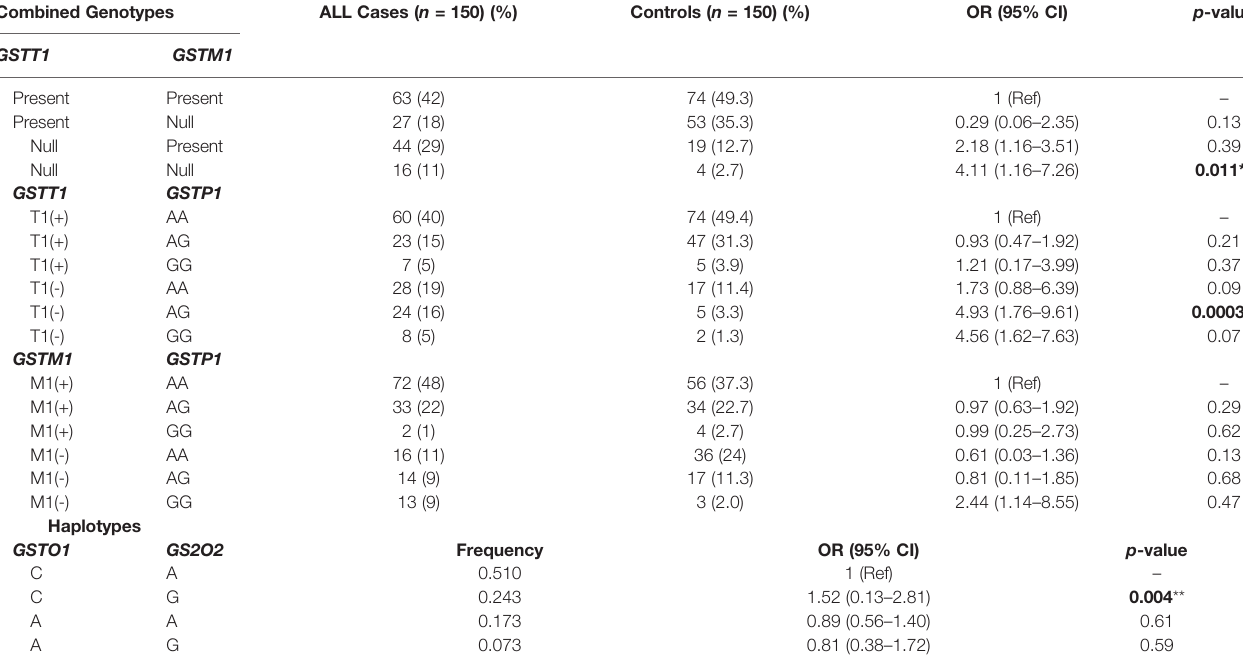
TABLE 3 | Combined genotype and haplotype analysis of GST polymorphisms in ALL patients and controls. Combined Genotypes ALL Cases ( n = 150)